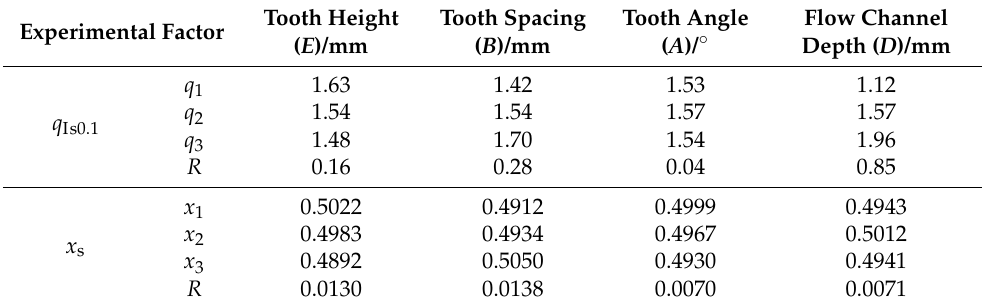
Table 4. Range analysis table of orthogonal